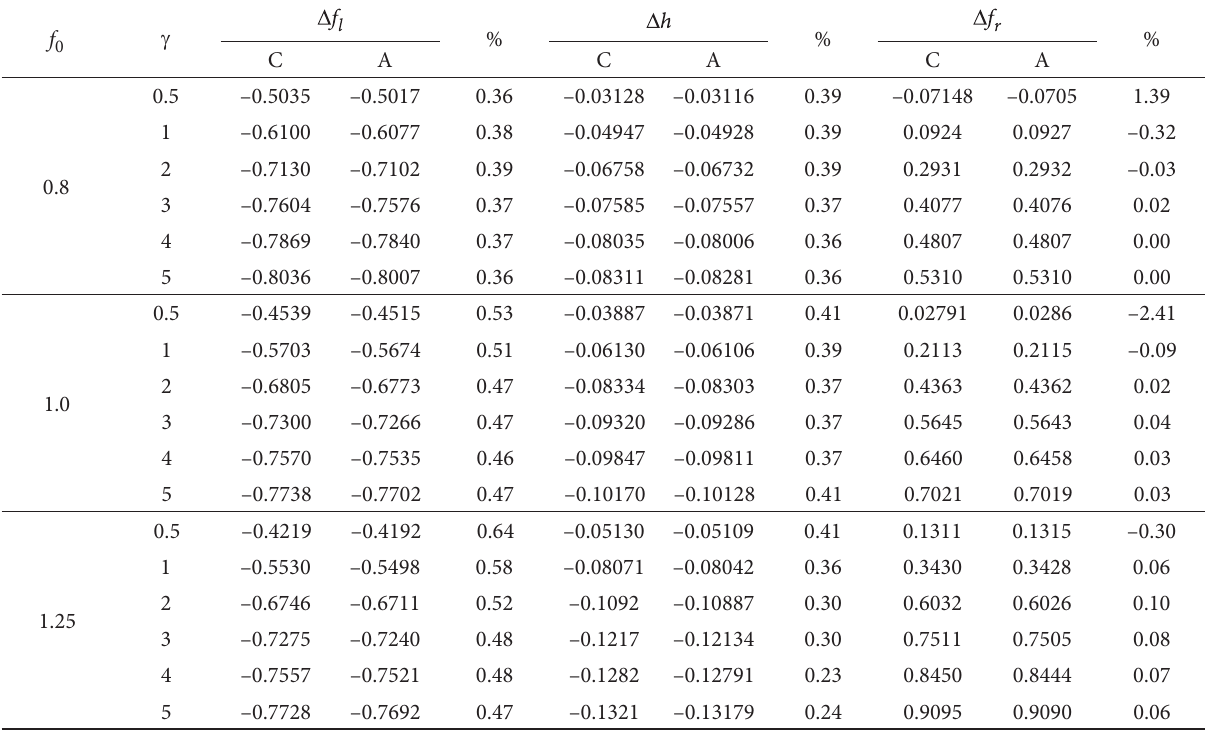
Table 1. General displacement values delivered by Cosmos/M (C) program and after the engineering calculation (A) f 0